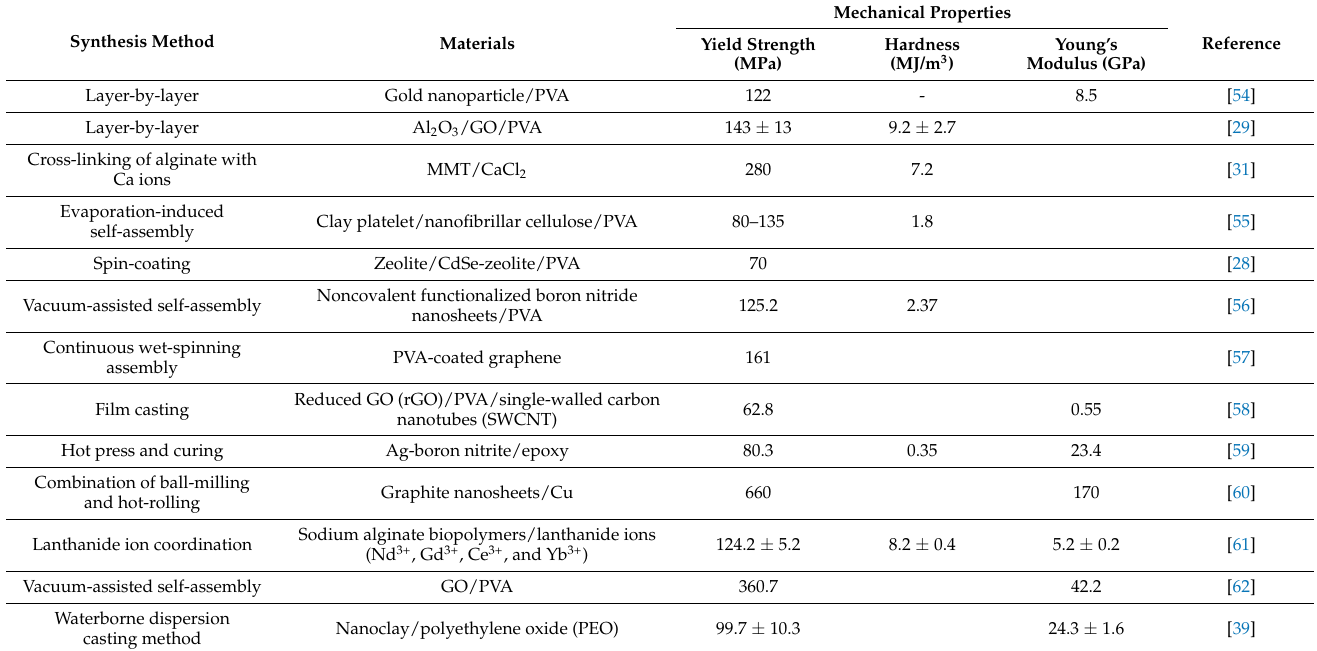
Figure 4. Layer-by-layer bottom-up assembly of multilayered Al 2 O 3 /GO − PVA artificial nacre. ( a ) GO and PVA. ( b ) Mixing of PVA and GO nanosheets. ( c ) Spin coating one layer of GO − PVA onto a glass substrate. ( d ) Assembling silane-modified Al 2 O 3 microplatelets into a monolayer at the air − water interface. ( e ) Transferring the assembled Al 2 O 3 monolayer onto the GO − PVA layer. ( f ) The obtained flexible, foldable artificial nacre after sequential repetition. Reproduced from ref. [29] with permission of the American Chemical Society. Table 1. List of mechanical properties of layered composite mimicking nacre.